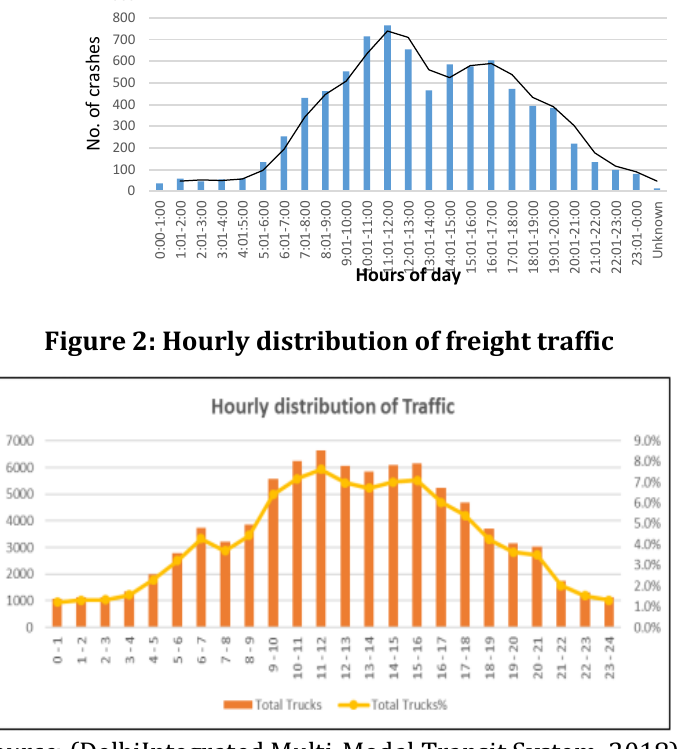
Source : (DelhiIntegrated Multi-Modal Transit System,